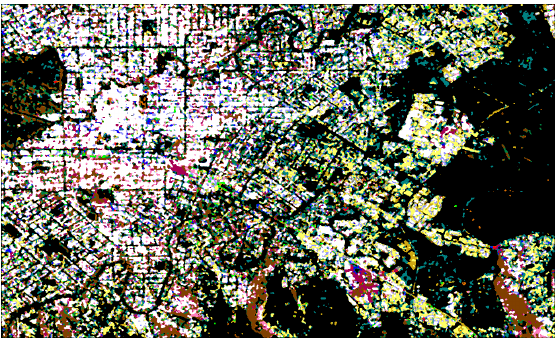
Figure 7. Comparison of the amplitude and coherence changes before and after the Christchurch earthquake; the meaning of the colours is given in Table 1